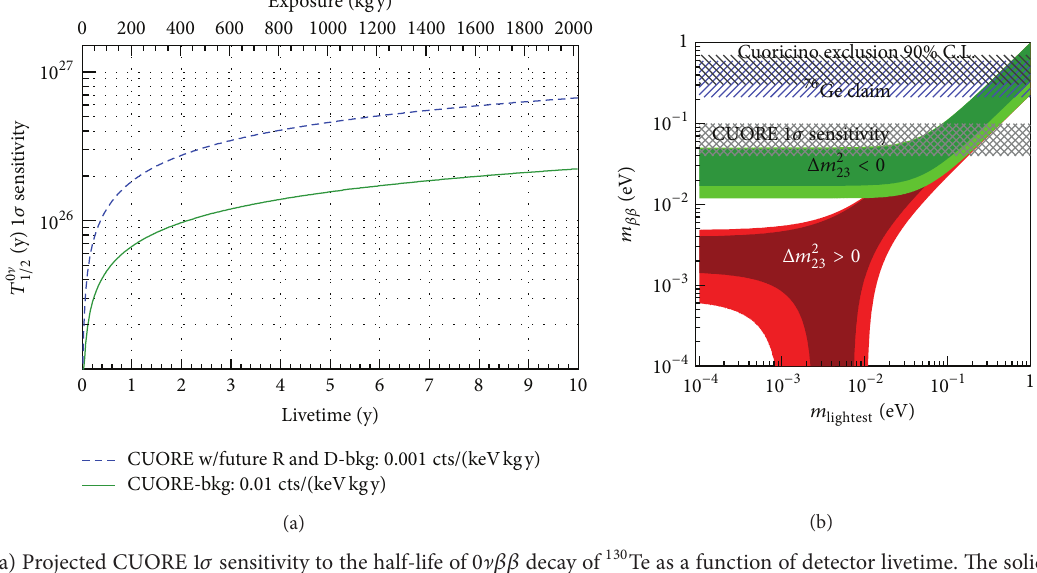
Figure 8: (a) Projected CUORE 1 𝜎 sensitivity to the half-life of 0 ] 𝛽𝛽 decay of 130 Te as a function of detector livetime. The solid green line shows the sensitivity for the target background rate of 0.01 counts/keV/kg/y, while the dashed blue line shows a speculative future scenario in which the background is ten times lower. (b) The corresponding 1 𝜎 sensitivity to effective Majorana mass versus the lightest neutrino mass after five years of detector livetime. The spread in the projected CUORE 𝑚 𝛽𝛽 bands arises from uncertainties in calculations of the nuclear matrix elements used to convert a measured half-life into an effective Majorana mass. The green band labeled Δ𝑚 2 23 < 0 denotes the inverted neutrino mass hierarchy while the red band labeled Δ𝑚 2 23 > 0 indicates the normal mass hierarchy. For both, the darker inner bands represent regions allowed by the best-fit neutrino oscillation parameters in the PMNS matrix, while the lighter outer bands extend to 3 𝜎 coverage. Both figures are from